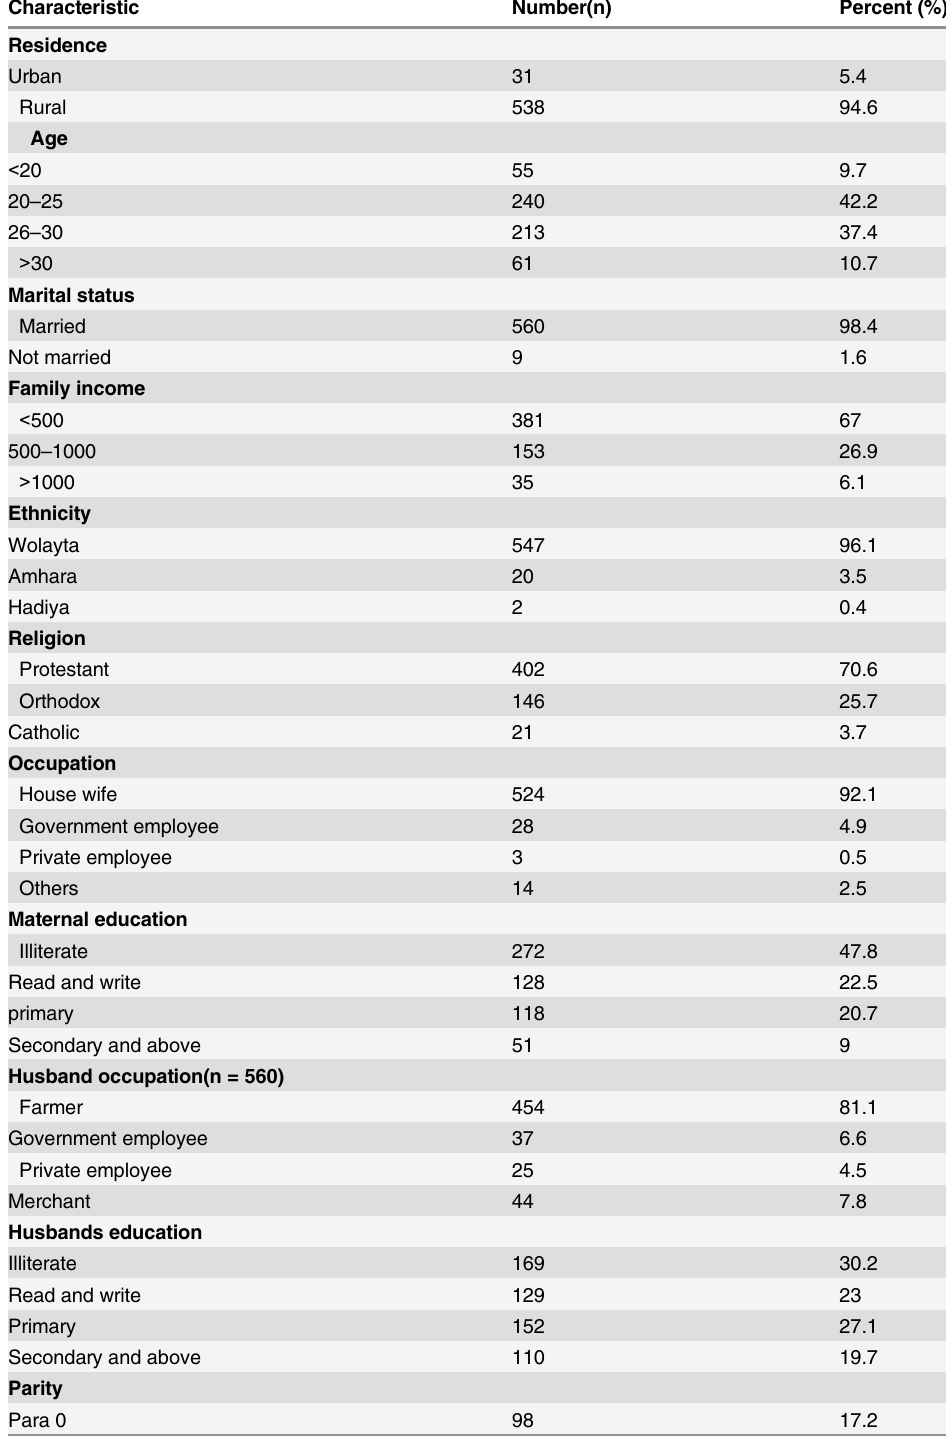
Table 1. Socio-demographic and obstetric characteristics of pregnant women in Duguna Fango Dis- trict, 2013 (n = 569). This table shows the socio-demographic and obstetric characteristics of the participants in the study